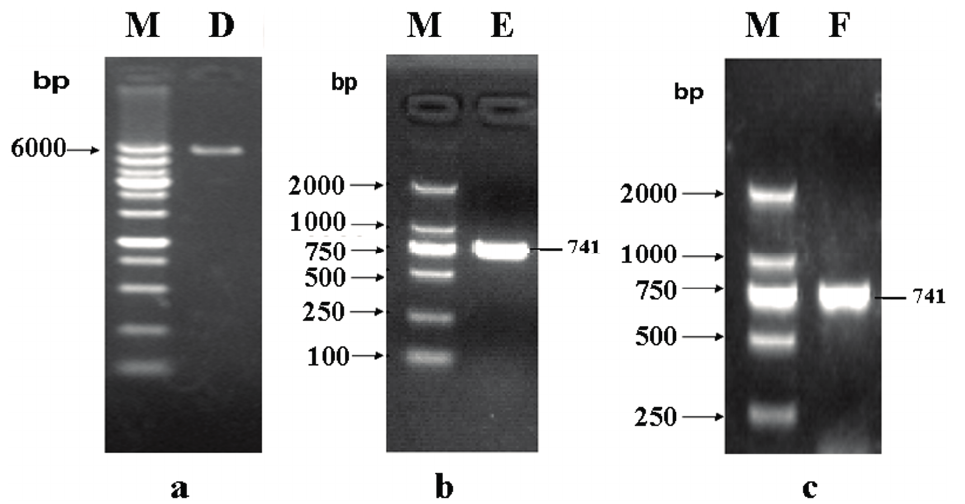
Figure 2. Construction of recombinant plasmid pET32a (+) S-phoN2. ( a ) Line D, the line of linear vector pET32a (+) S (5900 bp). Line M, DL6000 Marker; ( b ) Line E, the line of phoN2 (741 bp). Line M, DL2000 Marker; ( c ) Line F, PCR products of recombinant plasmid pET32a (+) S-phoN2. Line M, DL2000